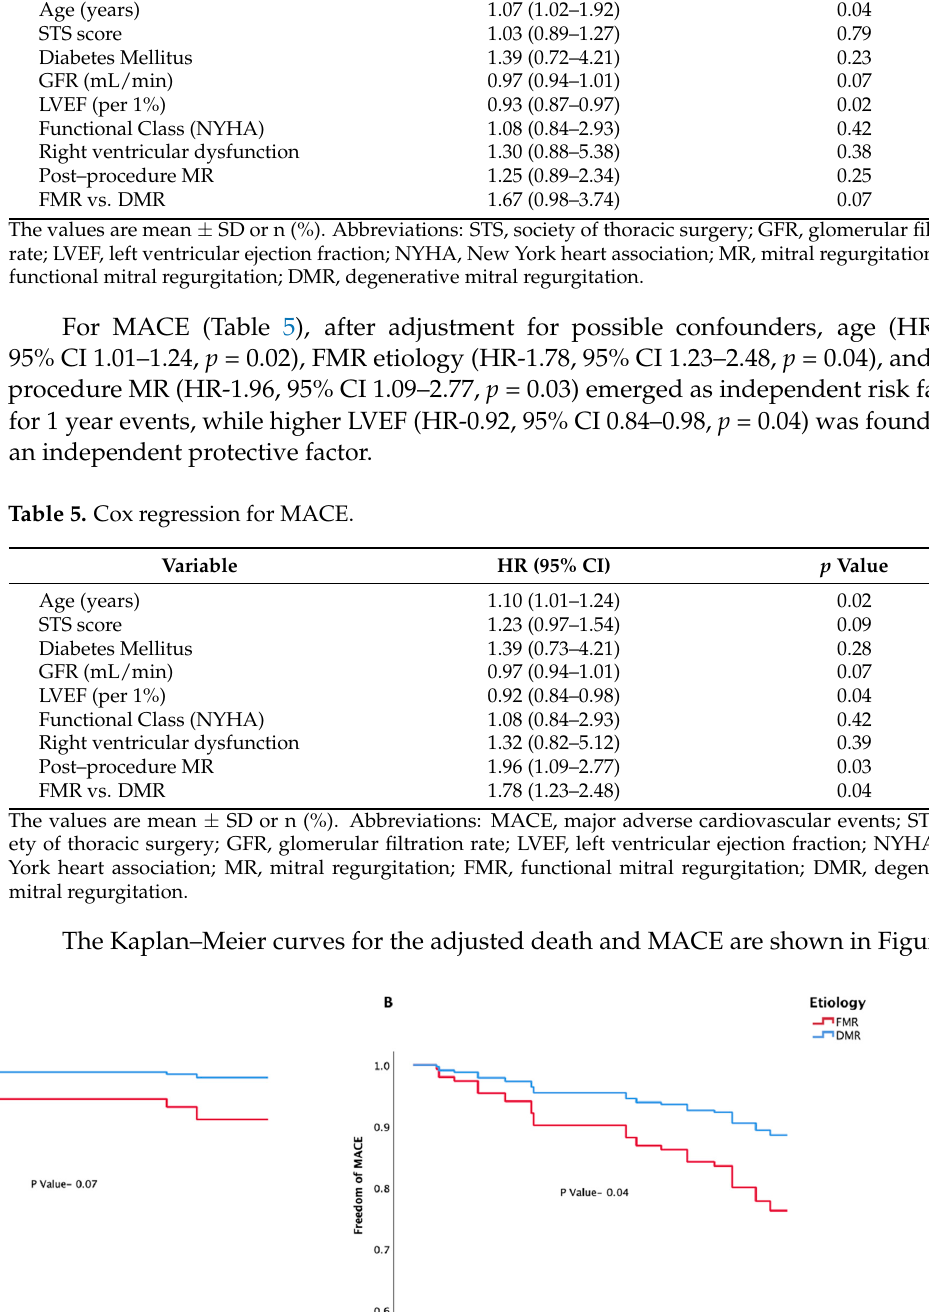
Table 4. Cox regression for Death.